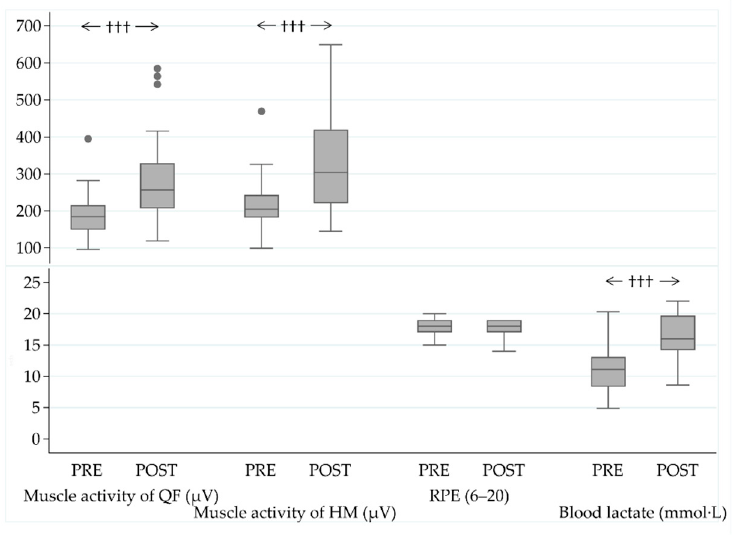
Figure 4. Muscle activity of the quadriceps femoris (QF) and hamstring (HM) muscles, acute responses in ratings of perceived exertion (RPE), and blood lactate (BLa) values after the military simulation test (MST) at the baseline (PRE) and in the end (POST) of the military operation. ††† p < 0.001 (Wilcoxon signed rank test).